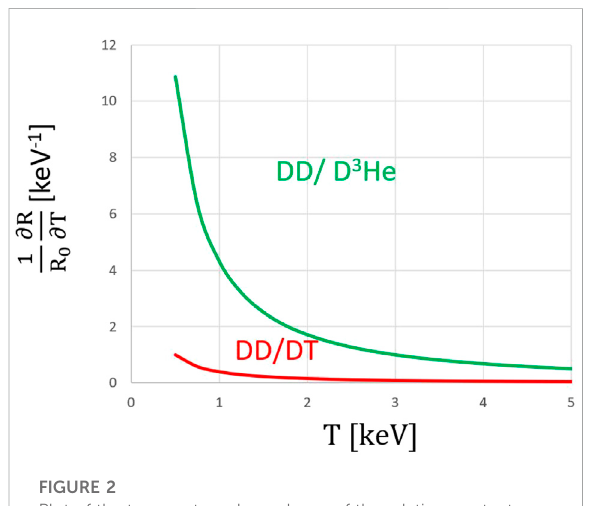
FIGURE 2 Plot of the temperature dependance of the relative reactant reactivities ( R (cid:2) σ v 12 / σ v 11 ) for DD and